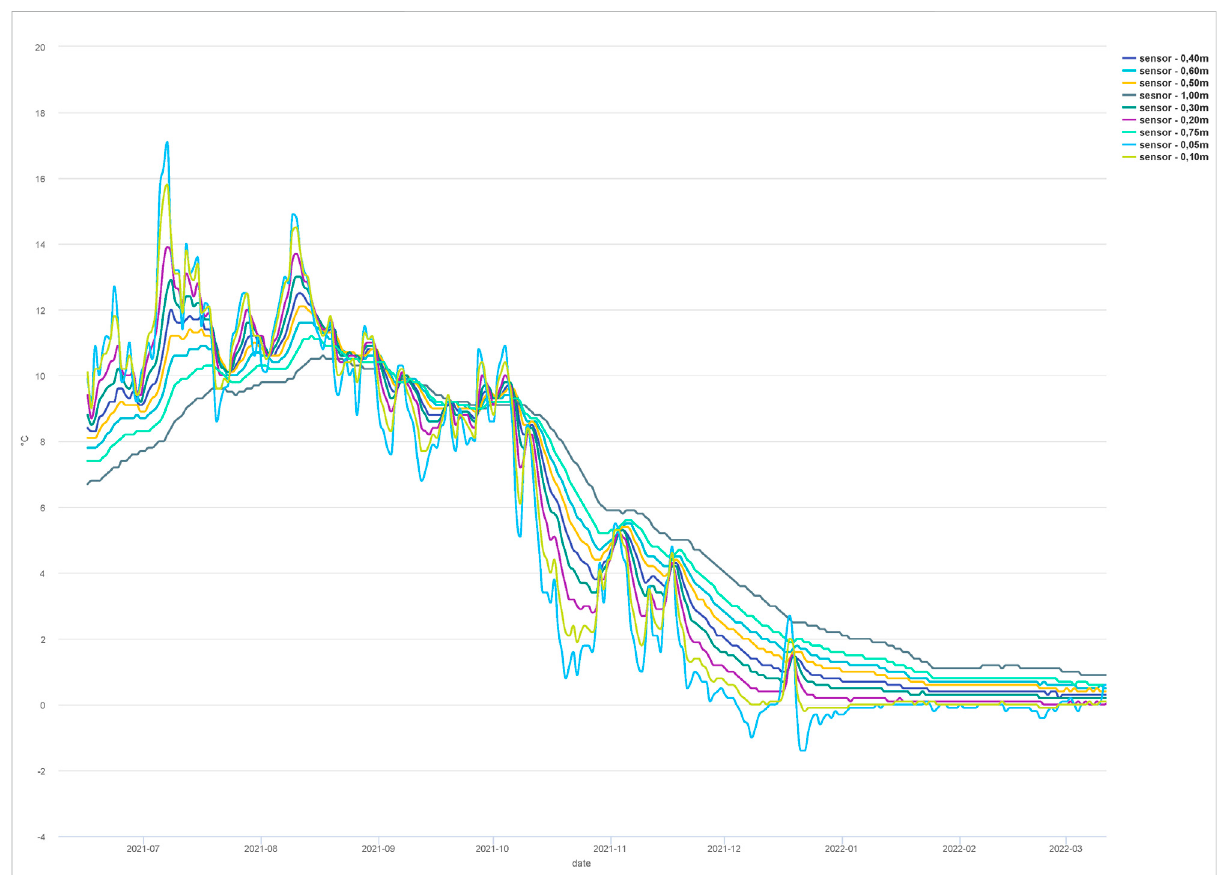
FIGURE 13 Sjåberget Andøya monitoring point, soil temperature plot, from installation 8 June 2021 — 11 March 2022. Plot by Lars Krangnes, Cautus Geo, from CautusWeb